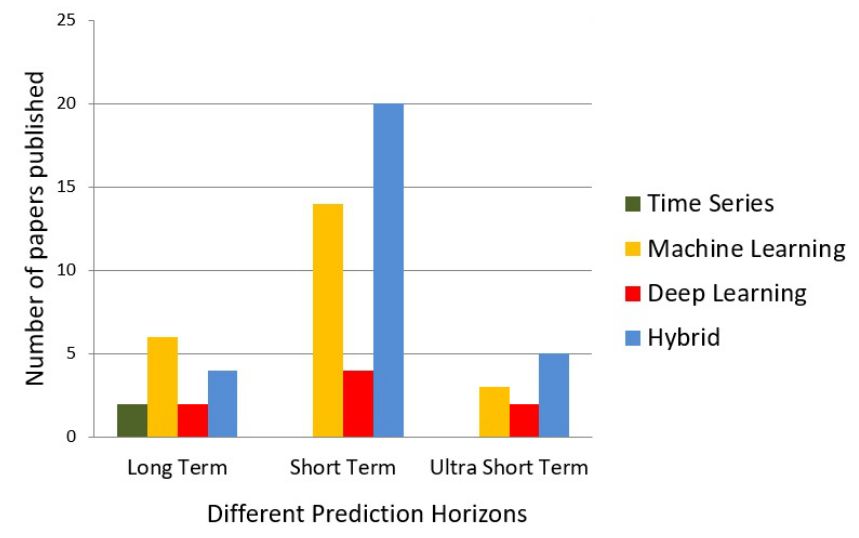
Figure 2. Distribution of different categories of articles